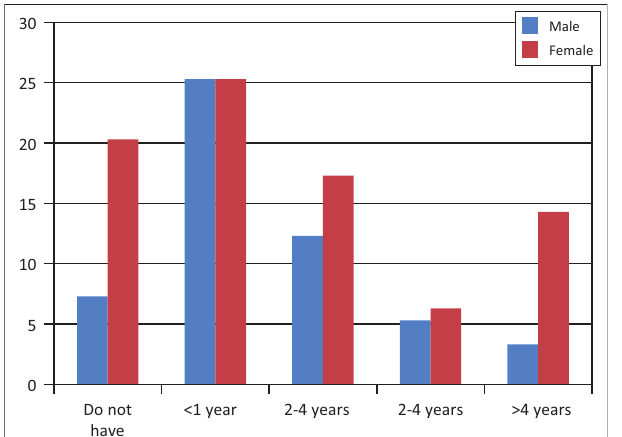
FIGURE 8: Gender of respondents and age of cellular devices.